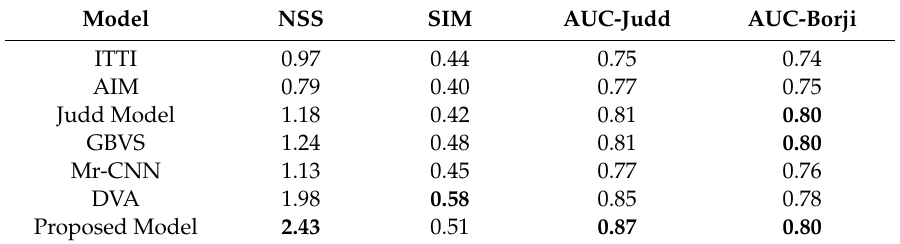
Table 2. Comparison of the quantitative scores of several models for the MIT300 [31] dataset.